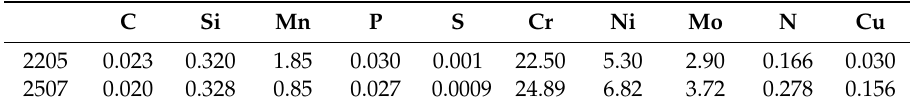
Table 1. Chemical composition of duplex stainless steel (DSS) and superduplex stainless steel (SDSS) (wt %).